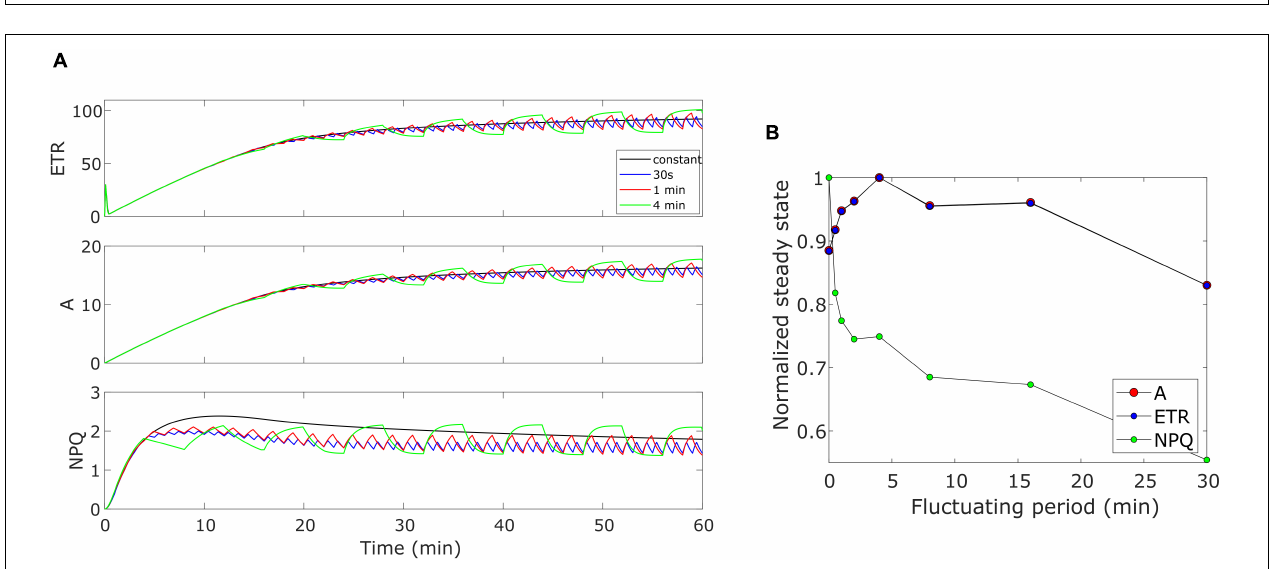
FIGURE 7 | Sensibility analysis of the model parameters for both MinnGold and Eiko. The parameters have been perturbed of ± 5% around the value in Table 1 , and the relative deviation from baseline simulation of the model output was calculated.